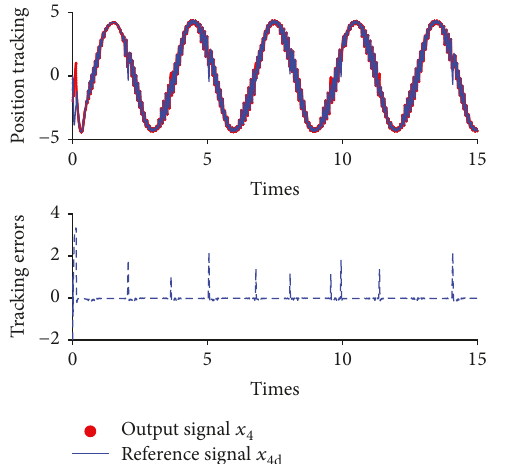
Figure 7: The control results and tracking error of x sin 2/3 π t .